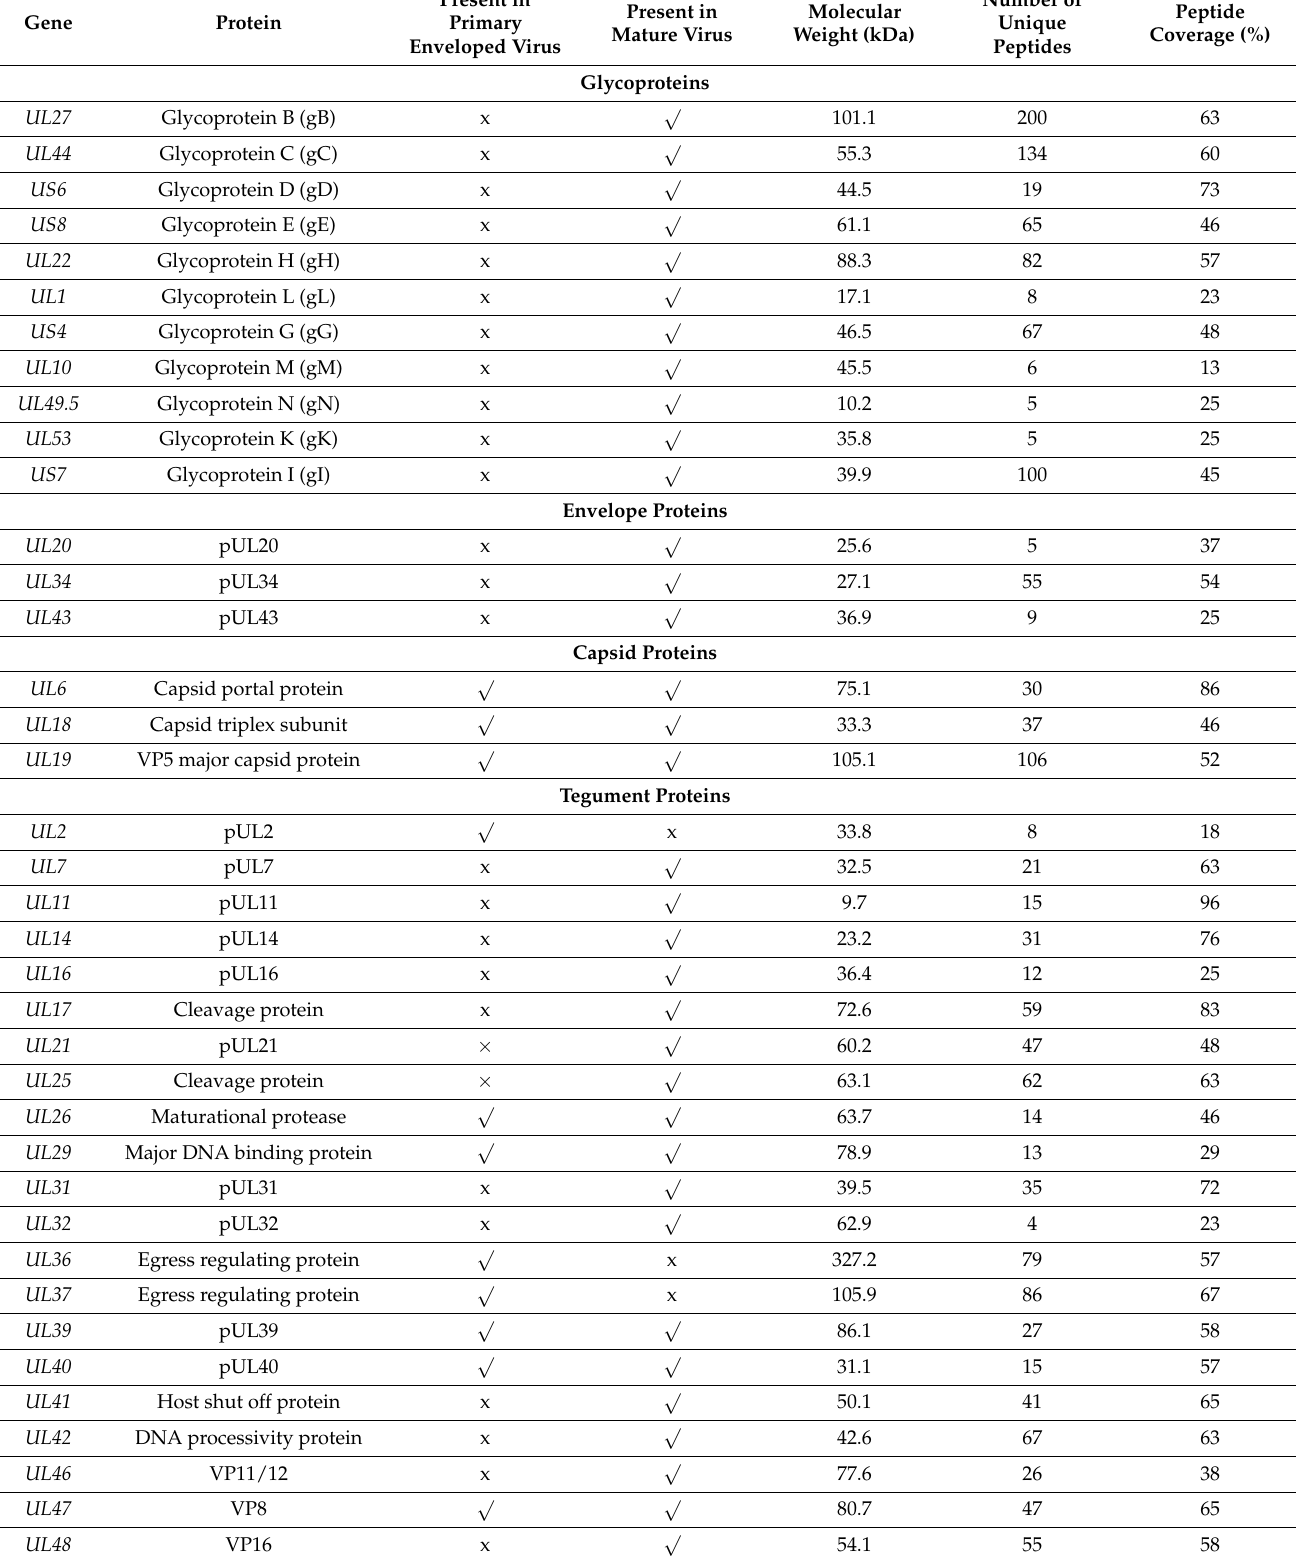
Table 1. Comprehensive list of proteins detected by mass spectrometry